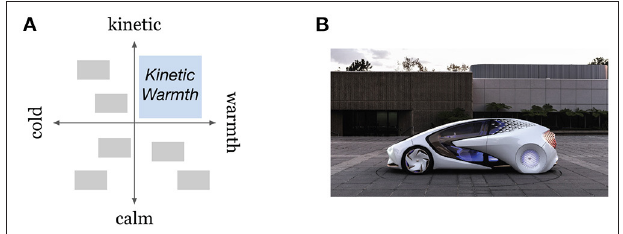
FIGURE 1 | (A) Character space (CS) for “kinetic warmth.” (B) Toyota Concept-i design derived from “kinetic warmth” ( © 2021 Toyota Motor Sales, U.S.A.,